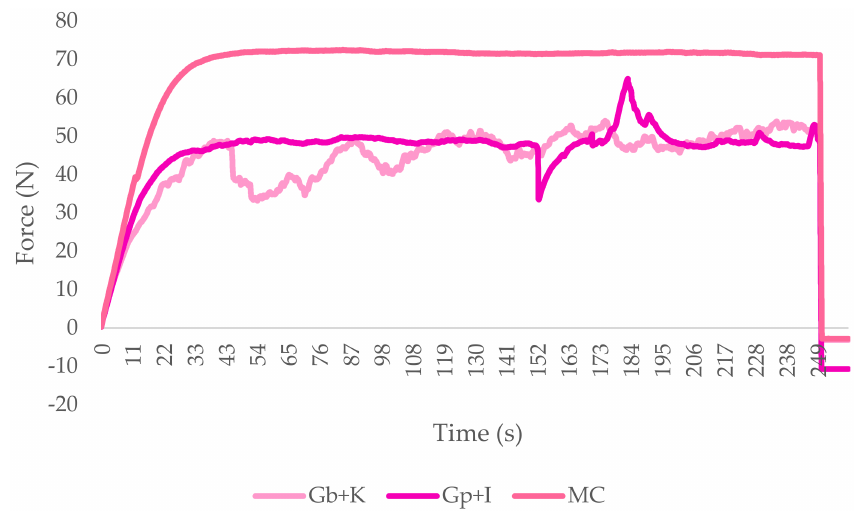
Figure 2. Representation of extrusion curves for each gel (Gp + I: porcine gelatin plus iota carrageenan; Gb + K: bovine gelatin plus kappa carrageenan; MC: methylcellulose).